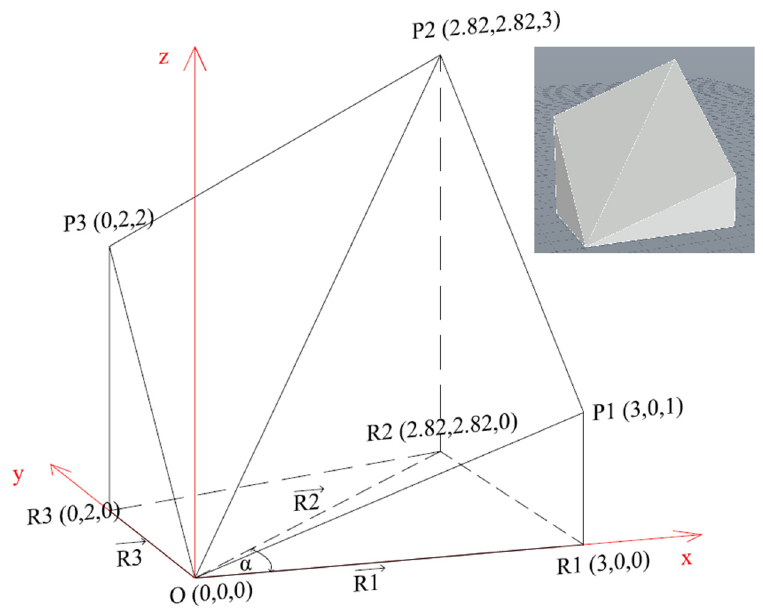
Figure 2. An example of a complex polyhedron for evaluating an alternative against three criteria.